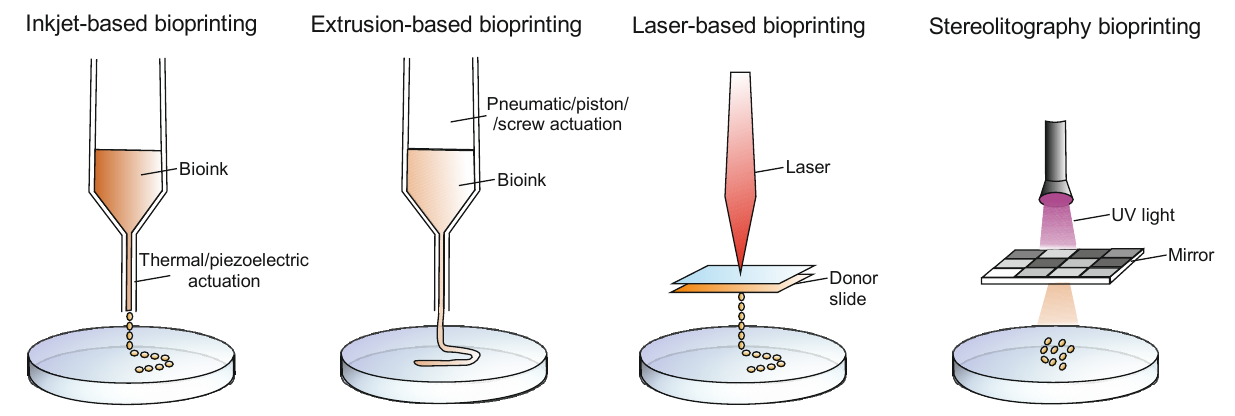
Figure 2. Graphical presentation of principles of four types of 3D-bioprinting techniques.